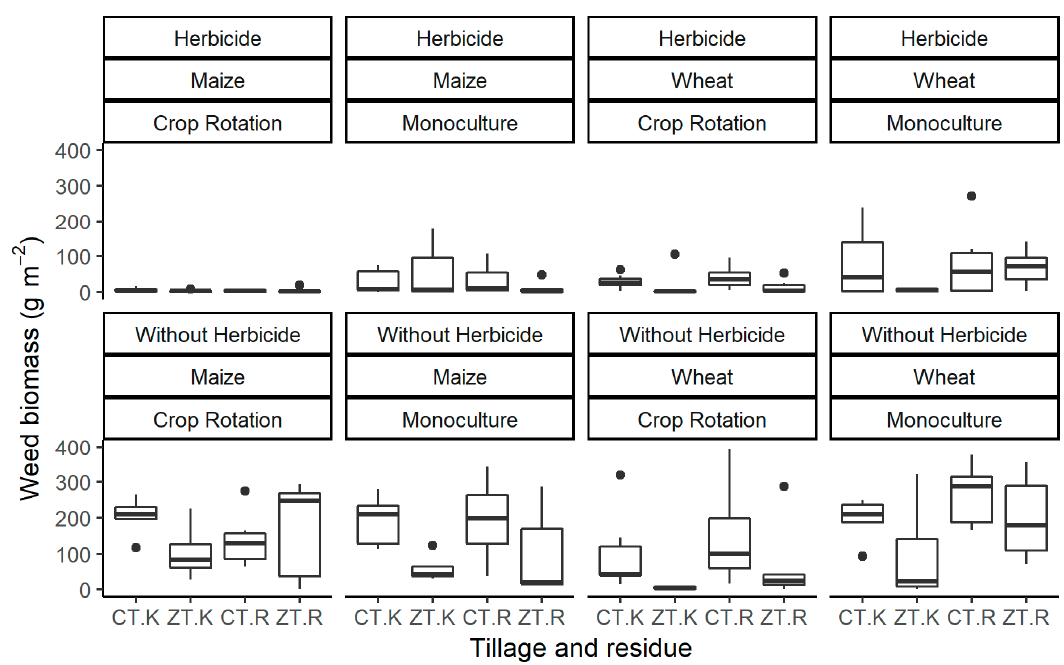
Figure 1. Boxplots of weed biomass observed in 2005, 2013, 2014 and 2015 with and without herbicide application in terms of crop, crop rotation, tillage and residue management. CT: Conventional tillage; ZT: Zero tillage; R: Remove all residues; K: Keep all residues. n = 6 (maize) and 8 (wheat). Table 4. Analysis of variance (ANOVA) of weed biomass per crop (wheat or maize) and per weed management (with or without herbicide application). * indicates significant e ff ects at p <